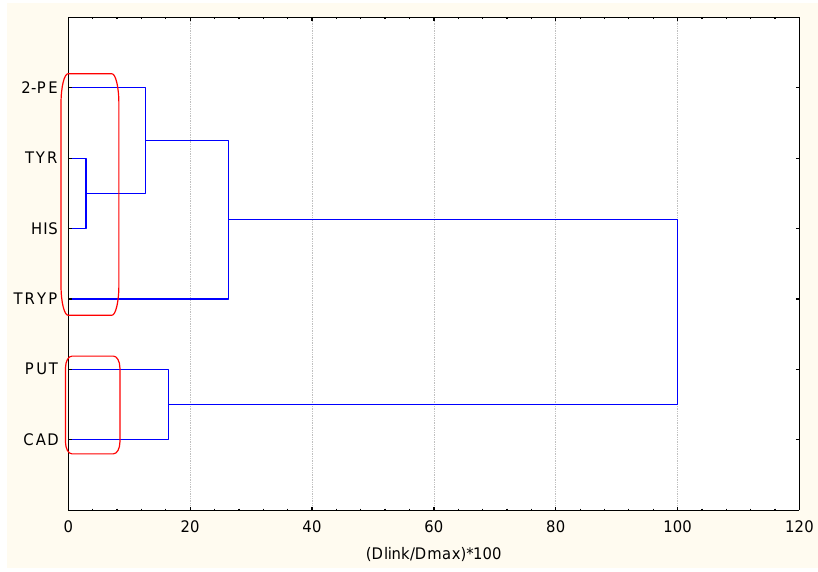
Figure 2. Variable clustering for Wine A.